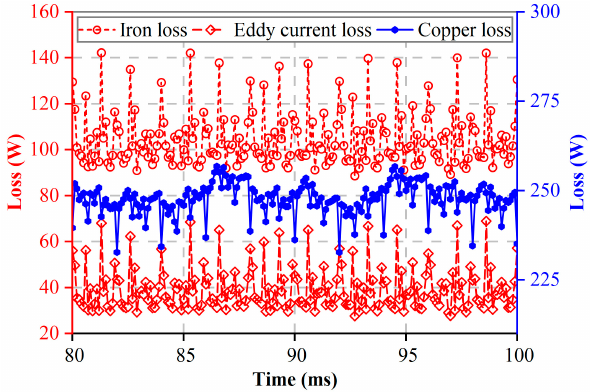
Figure 7. Loss power time-varying curves of PM-IWM during on-load condition.